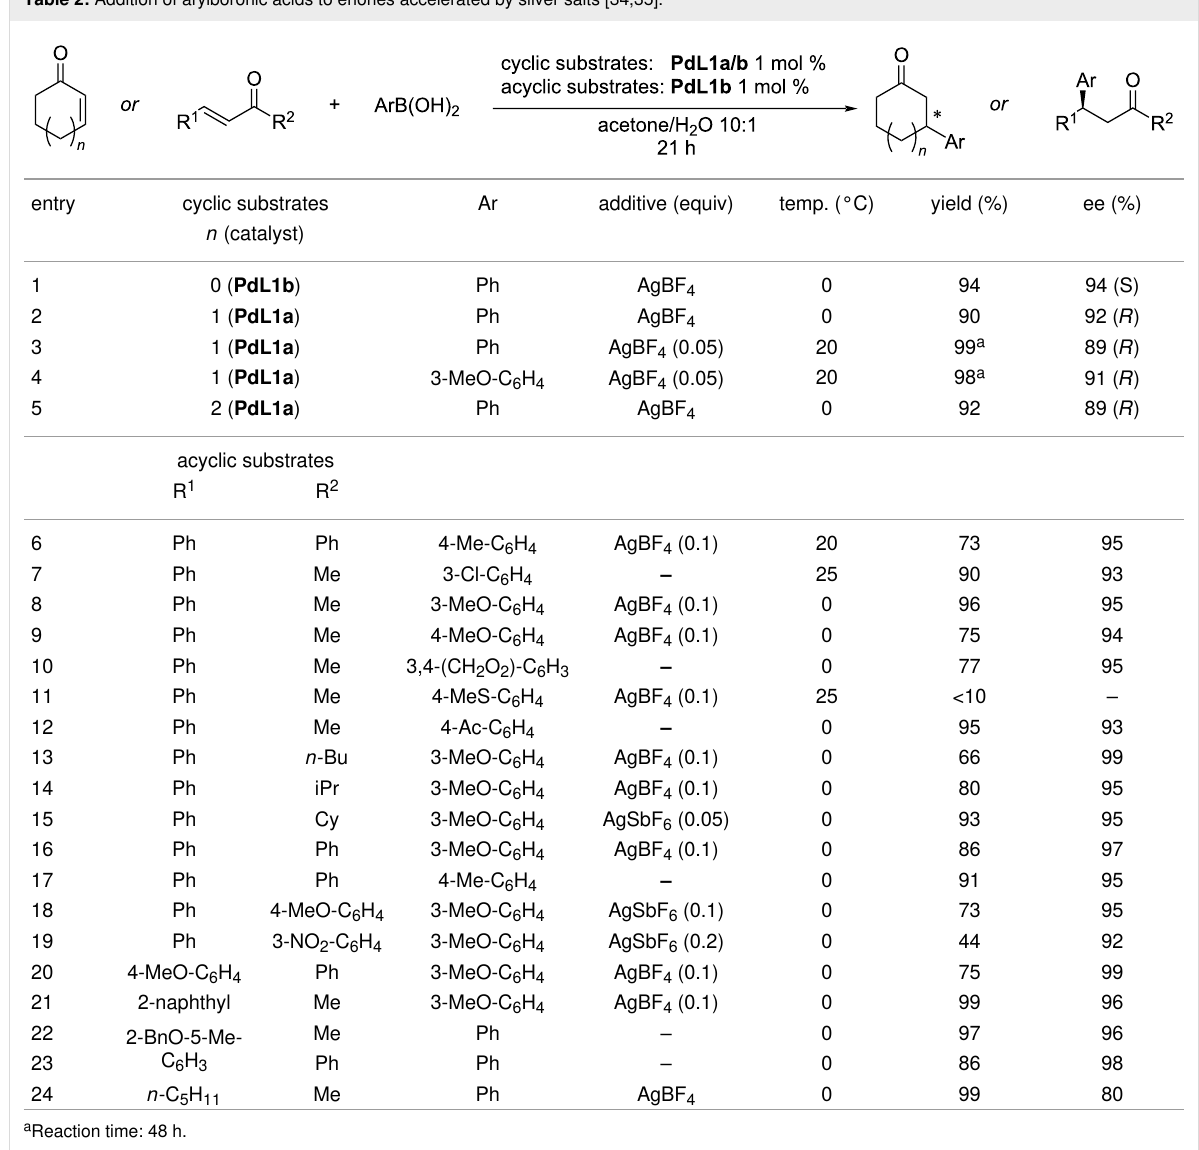
Table 2: Addition of arylboronic acids to enones accelerated by silver salts [34,35].